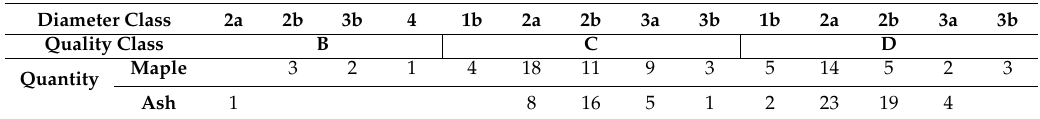
Table 4. Number of logs per species sorted after small-end diameter (inside bark) class and quality class according to RVR